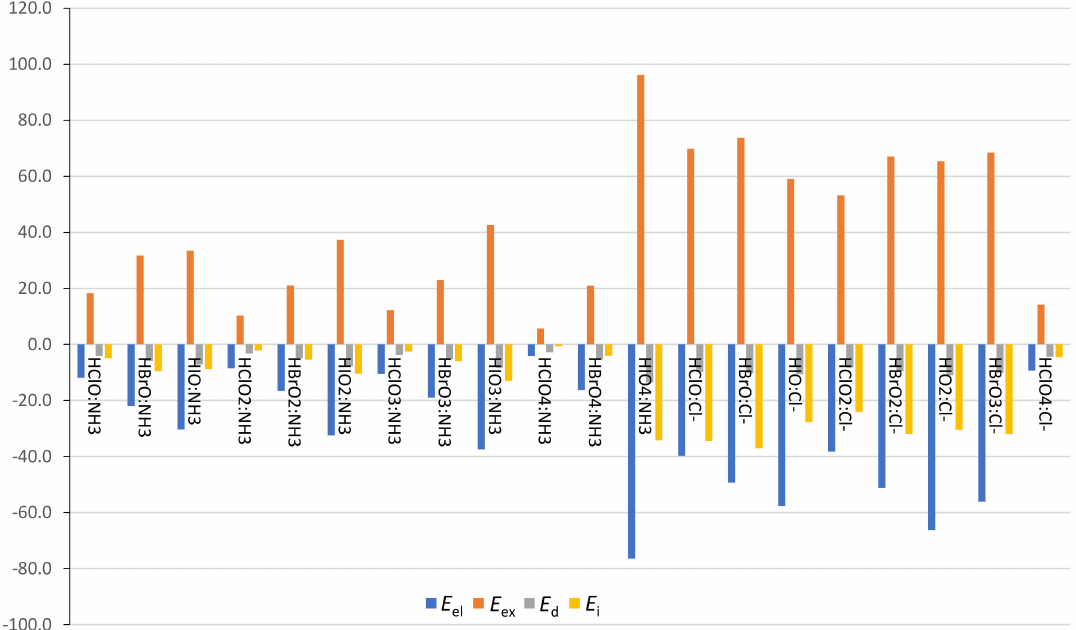
Figure 7. SAPT electrostatic, exchange, dispersion, and induction energy contributions ( E el , E ex , E d , and E i , respectively) of XB complexes. Energies in kcal · mol − 1